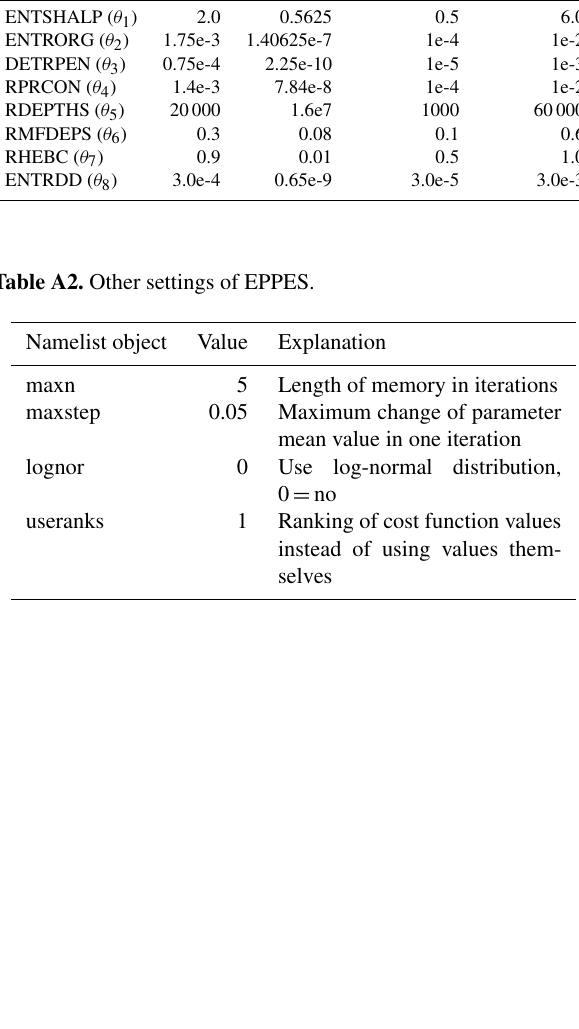
Table A1. Initial values of the convection parameters for EPPES. Parameter